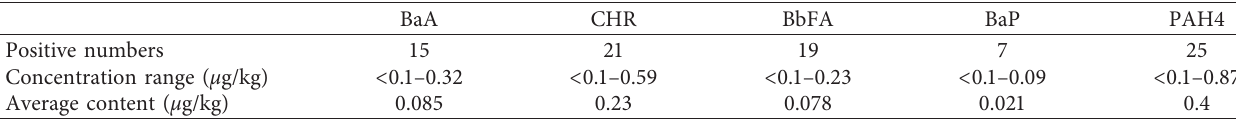
Figure 5: PAH4 content in 30 stage-1 infant formulas. Table 4: Detected PAH4 content in 30 stage-1 infant formulas.